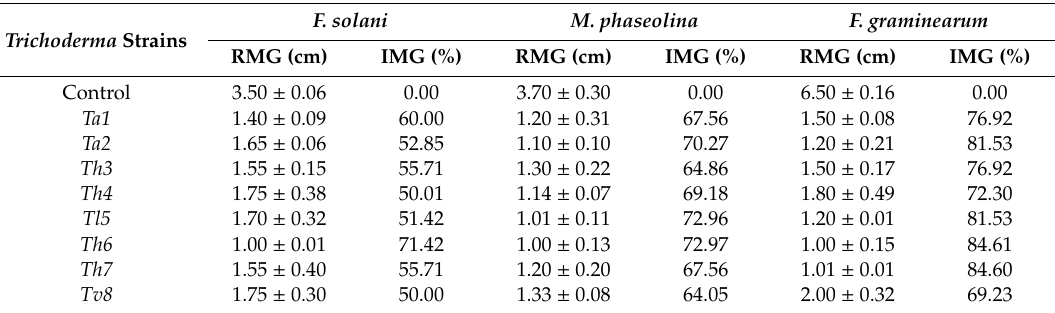
with the other two pathogenic fungi (Table 4). Table 4. Antagonistic activity of Trichoderma strains against three pathogenic fungi by dual culture technique. Trichoderma